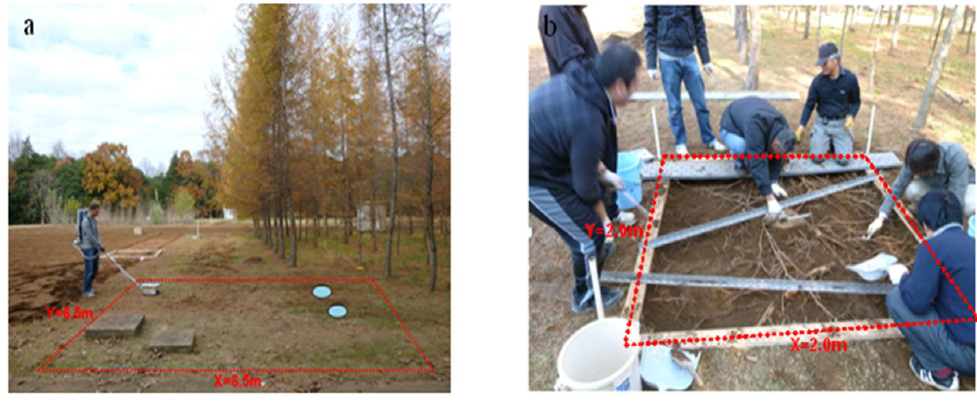
Figure 1. ( a ) Surveying scene of larch trees using 3D GPR, the red dotted lines show the survey area and the blue circles shows the locations of the larch tree stumps. ( b ) Excavating scene of one larch tree root, the red dotted lines show the excavation